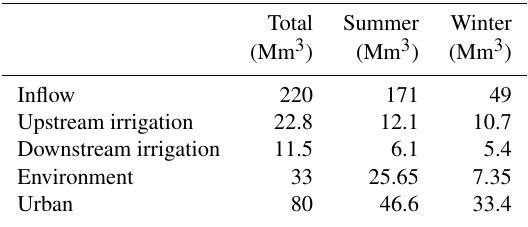
Table 1. Summary of the main hydroclimatic variables and water demand sources aggregated by sector. Total Summer Winter (Mm 3 ) (Mm 3 ) (Mm 3 ) Inflow 220 171 49 Upstream irrigation 22.8 Downstream